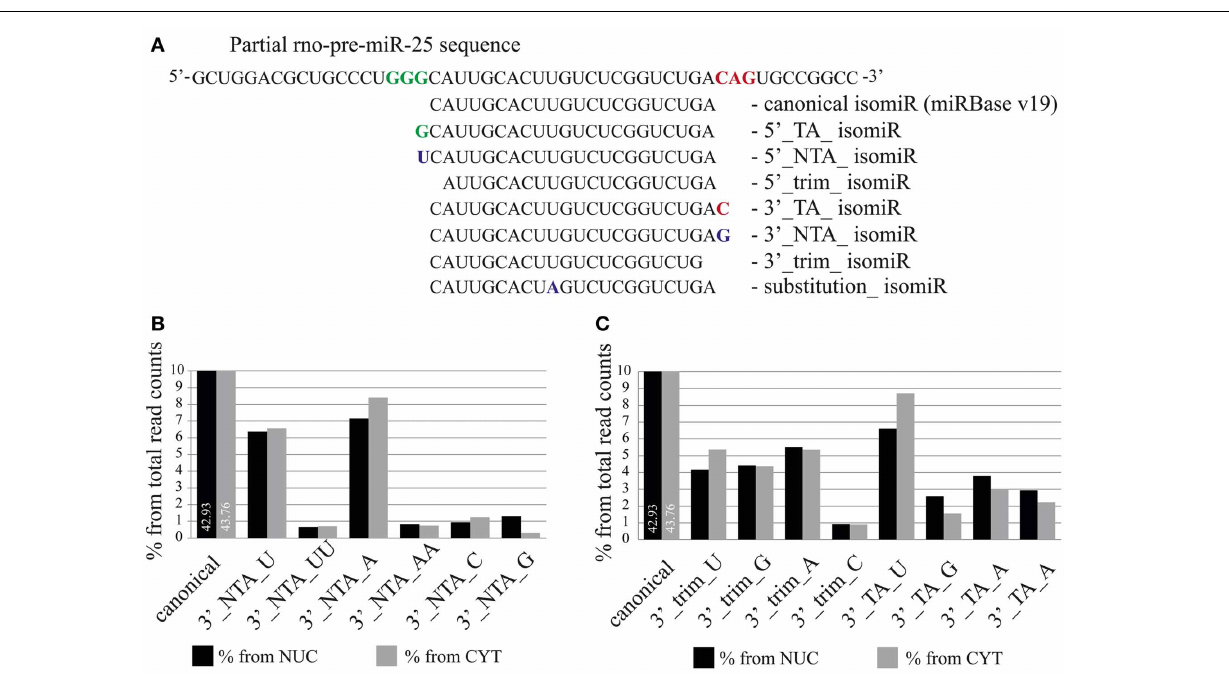
FIGURE 7 | The distribution of isomiRs between nuclear and cytoplasmic fractions of neurons. (A) Definition of different isomiR species. For illustration, miR-25 isomiRs aligned to the pre-mir-25 sequence are shown (TA, templated addition; NTA, non-templated addition; trim, trimmed). (B,C) Proportion of specific isomiRs from the